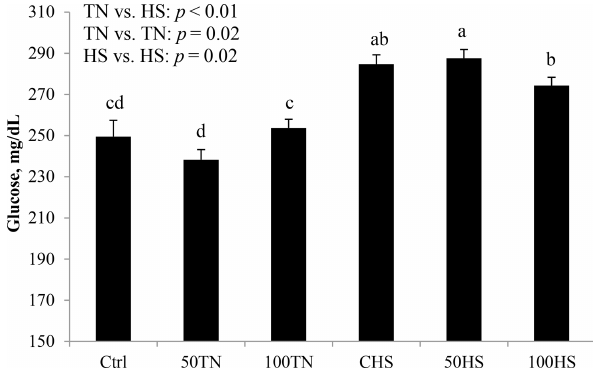
Figure 4. Effects of feeding different levels of organic zinc under TN and HS conditions on blood glucose in broiler chickens. Results are expressed as LSM ±